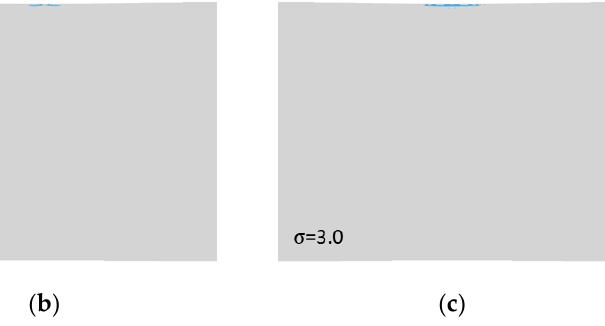
( f ) Figure 16. Cavitation features according to cavitation number. From ( a – f ), the cavitation number is 4.17 – 1.07 (experiment condition).